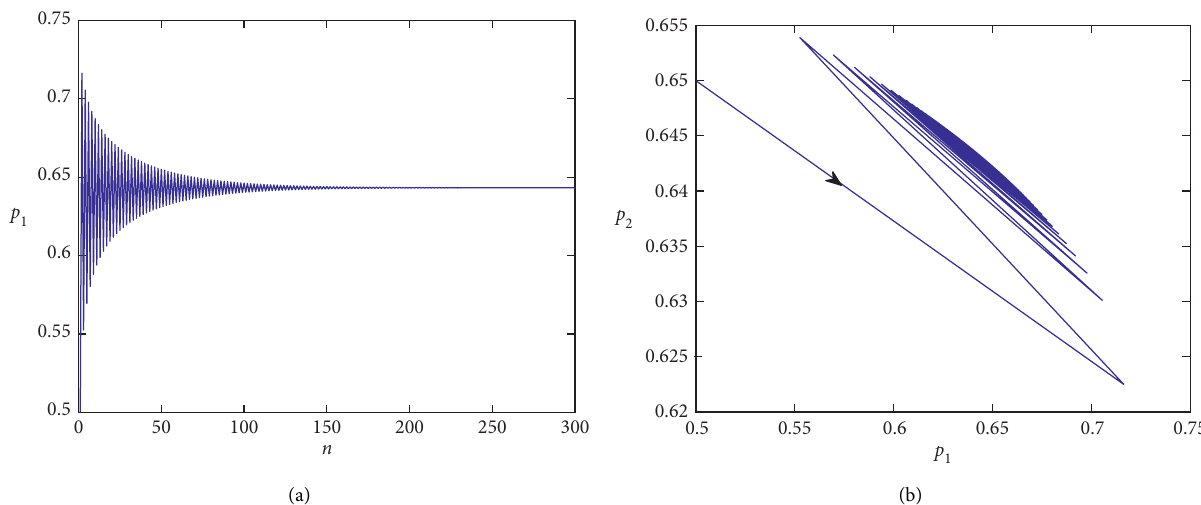
Figure 1: Stabilized states of duopoly pricing in system (14) with ( p portrait of two firms.